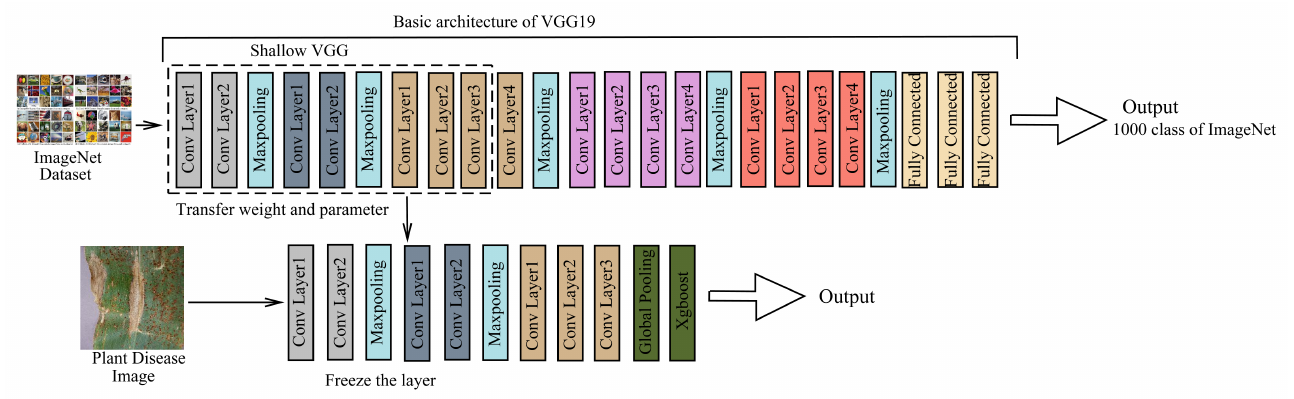
Figure 2. Basic VGG19 architecture with transfer learning process.